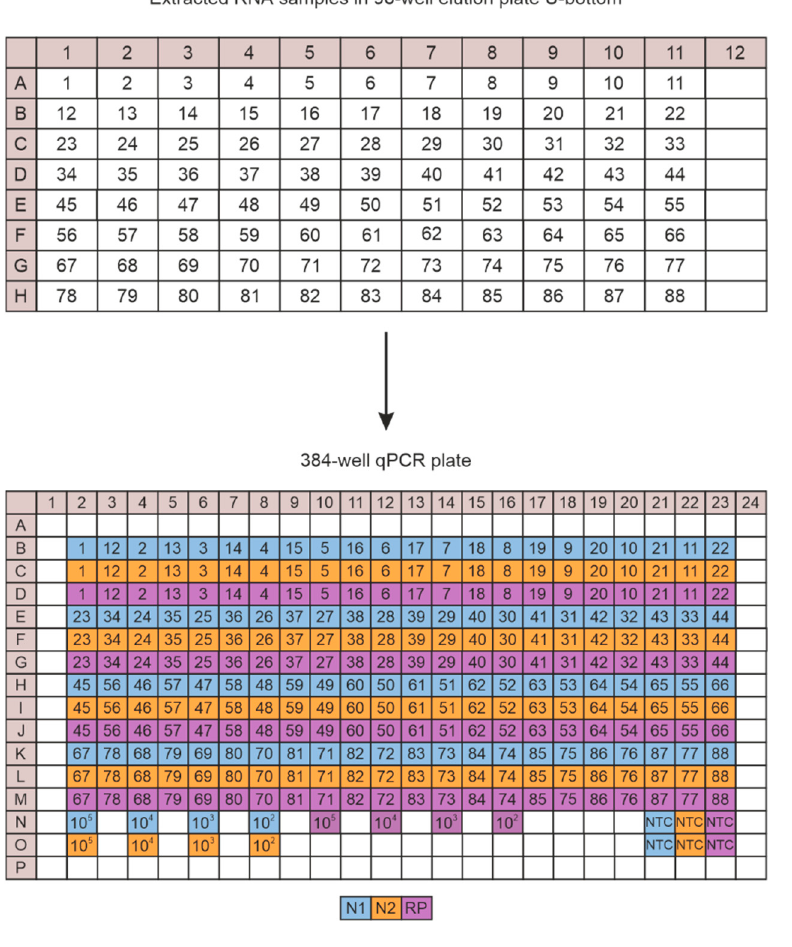
Figure 1. CFX plate loading scheme. Shown is the pipetting strategy for the transfer of extracted RNA from the 96-well elution plate to the 384-well qPCR plate using a 12-channel pipette in order to run a full plate RT-qPCR experiment that includes 88 samples measured with three primer/probe sets like N1 (blue), N2 (orange) and RP (purple). Four dilutions (10 5 , 10 4 , 10 3 , and 10 2 copies) of the RNA control as well as two no-template control reactions (NTC) for each primer/probe set are included.